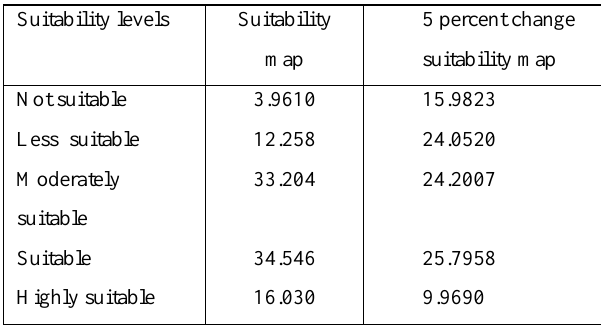
The same operation is performed at a change of 5 percent to detect the change with considerable detection in the change of suitability classes. LULC’s priority vector’s weight was reduced by 5 percent and the remaining criteria are increased by 5 percent to observe the change occurring.